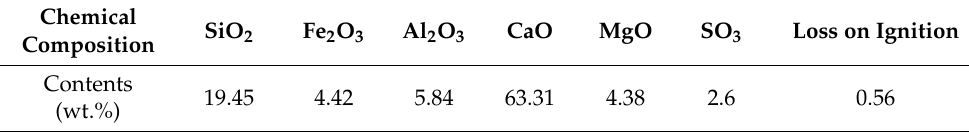
Table 1. Chemical composition of ASTM Type I Portland